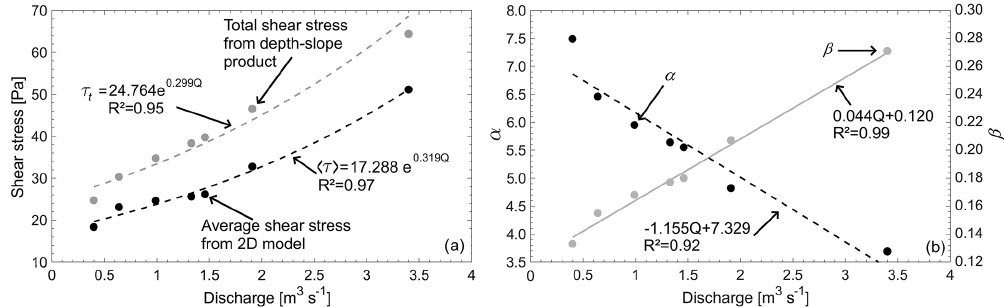
Figure 4. (a) Relationship between the reach-averaged shear stress ( (cid:104) τ (cid:105) ), 1D total shear stress ( τ t ), and discharge ( Q ). (b) Relationship between the parameters of the gamma function ( α and β ) and discharge. Total shear stress from depth slope product has a similar trend as (cid:104) τ (cid:105) , but it is consistently higher. All our results are based on the 2D models, and τ t is shown here only for comparison purposes.